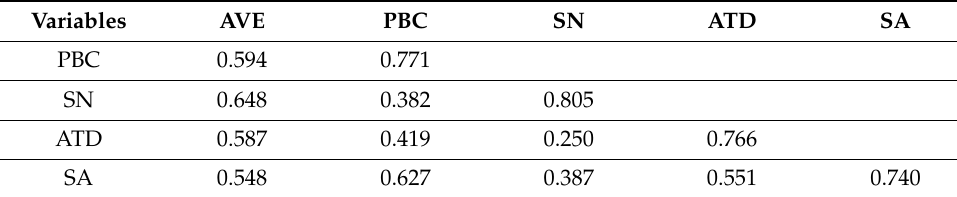
Table 5. Correlation characters via adjusted SEM simulation.